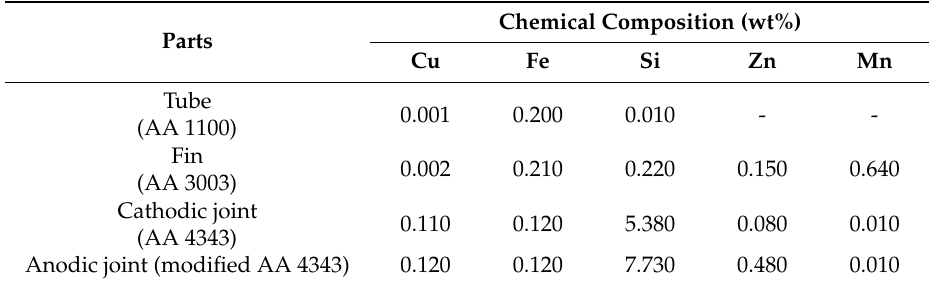
Table 1. Chemical composition of the parts (Al 1100, Al 3003, Al 4343 and modified Al 4343) of Al fin-tube heat exchanger. 125